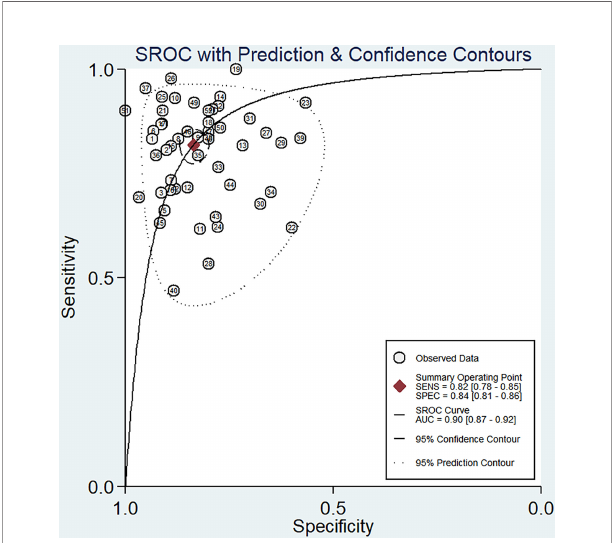
FIGURE 4 | Summary receiver operator characteristic (SROC) curve examining the overall accuracy of miRNAs in the diagnosis of diabetic retinopathy.